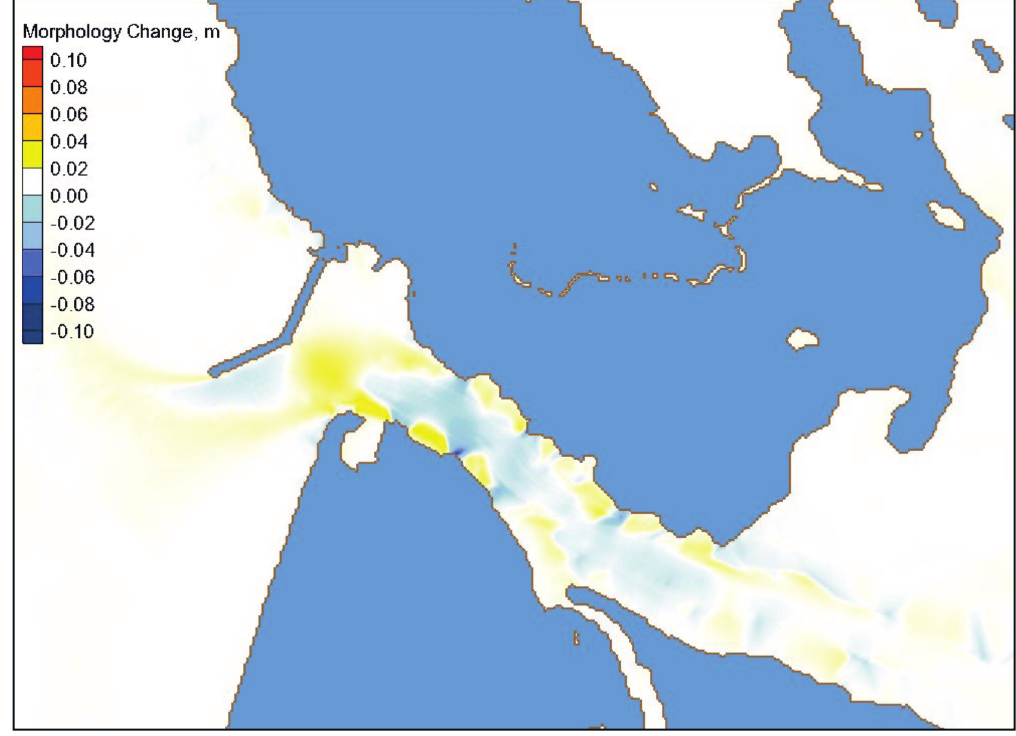
Figure 32. Calculated sediment accretion and erosion for Alt 2 under Hurricane Isabel.